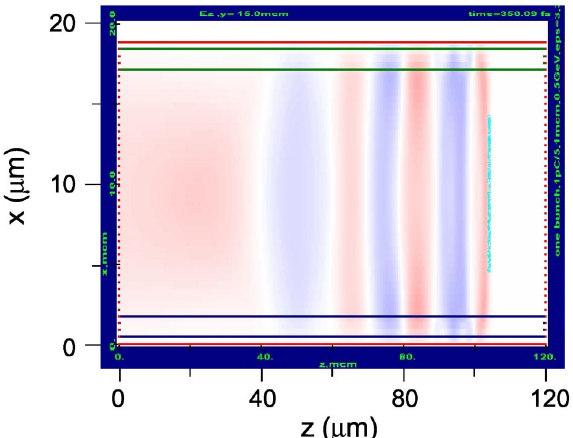
FIG. 5. (Color) Pattern when the bunch has traveled 350 fs from the point of entry on the left. It is seen that all the transition radiation region ( z < 40 (cid:4) m ), the interference region ( 40 < z < 60 (cid:4) m ), and the Cerenkov radiation region ( 60 < z < 105 (cid:4) m ) have expanded, with the Cerenkov radiation region filled with more than two periods of wakefield radiation.